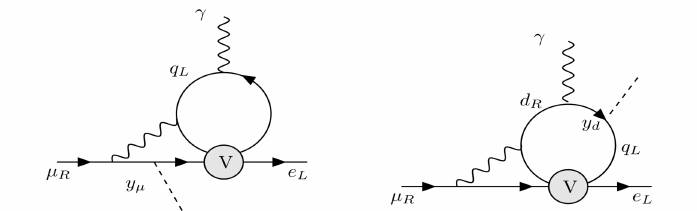
Figure 1 . On the left, a diagram mixing the tensor operator to the dipole (the Higgs leg is replaced by a mass insertion in the EFT below m tensor operators to scalars (the gauge boson can attach to any two legs not belonging to the same bilinear).